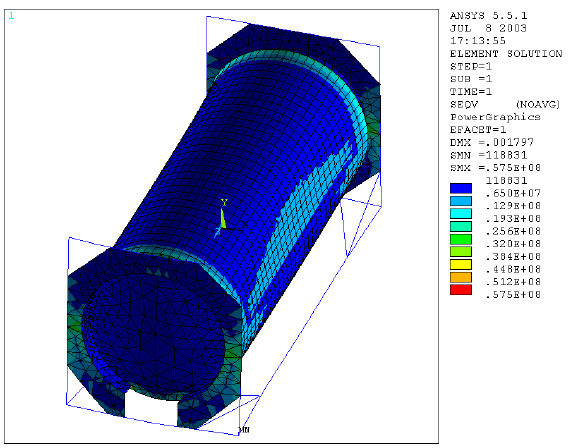
Figure 11. The equivalent stresses calculated according to Von Mises.